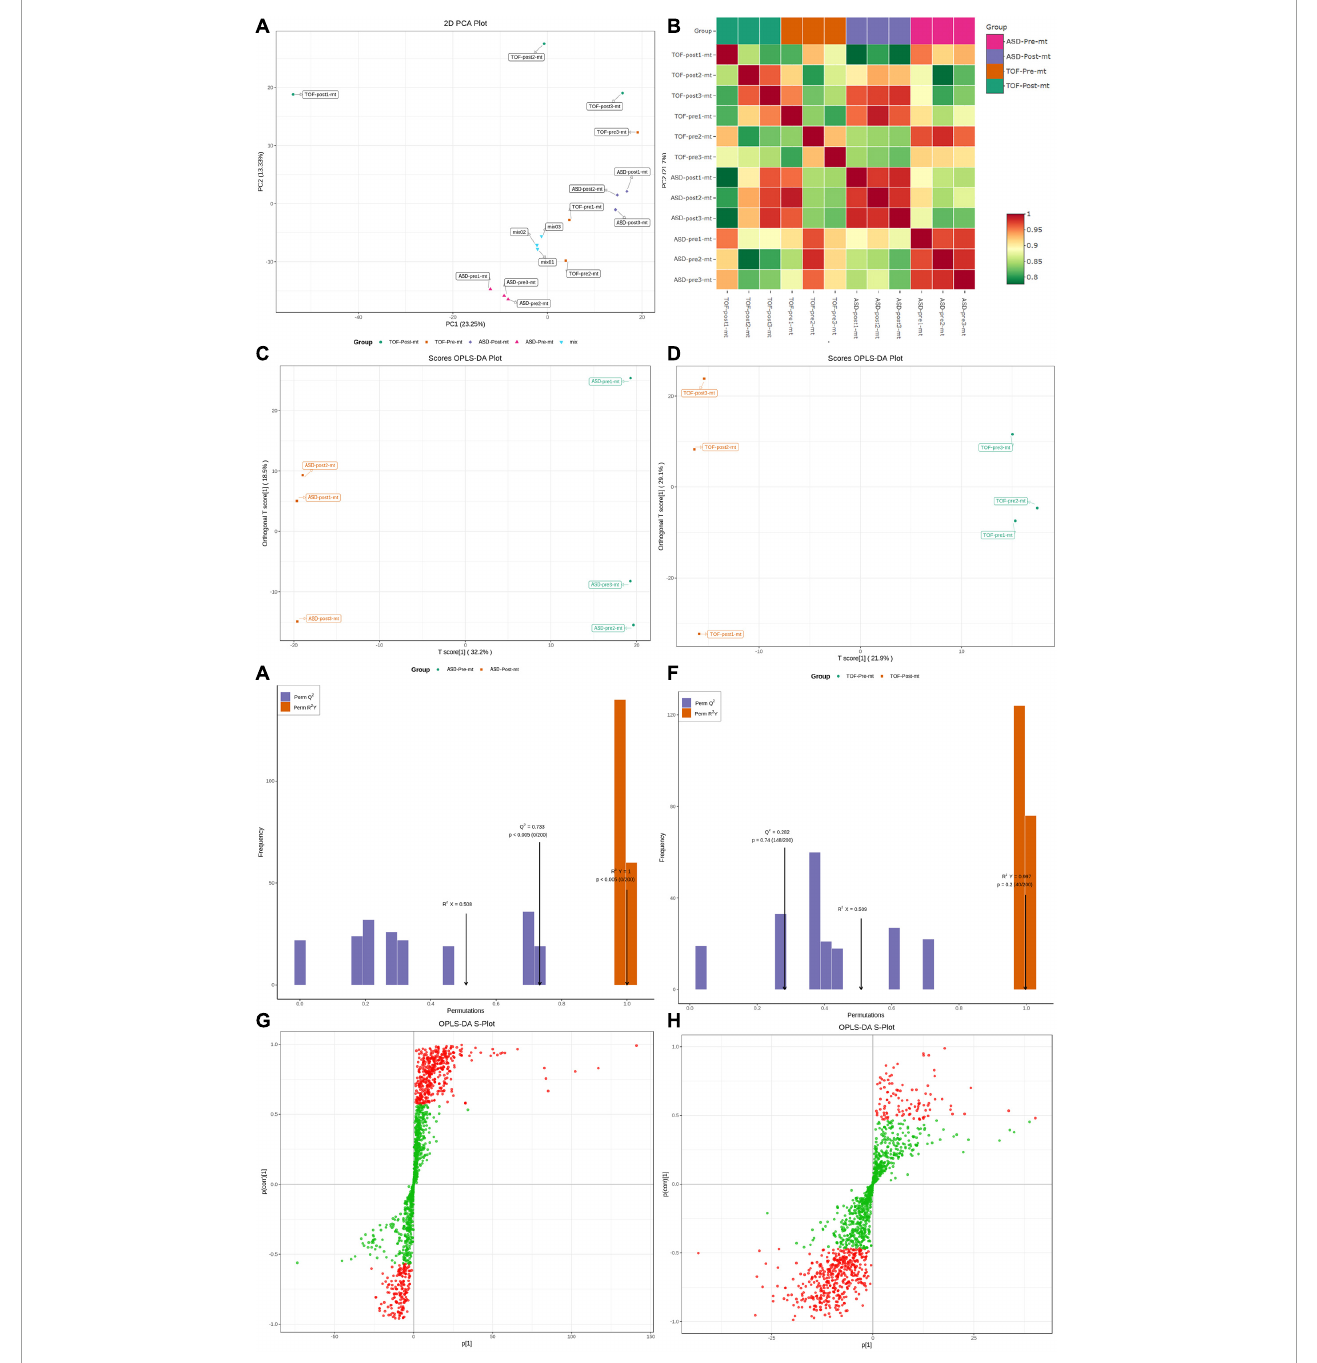
FIGURE4 Principal component analysis (PCA) and orthogonal partial least squares-discriminant analysis (OPLS-DA) of atrial septal defect (ASD) and tetralogy of fallot (TOF). (A) PCA for all samples. (B) Heatmap of sample distances. (C) OPLS-DA for ASD samples. (D) OPLS-DA for TOF samples. (E) Fitting analysis of ASD samples. (F) Fitting analysis of TOF samples. (G) S-plot analysis of metabolites in ASD samples. (H) S-plot analysis of metabolites in TOF